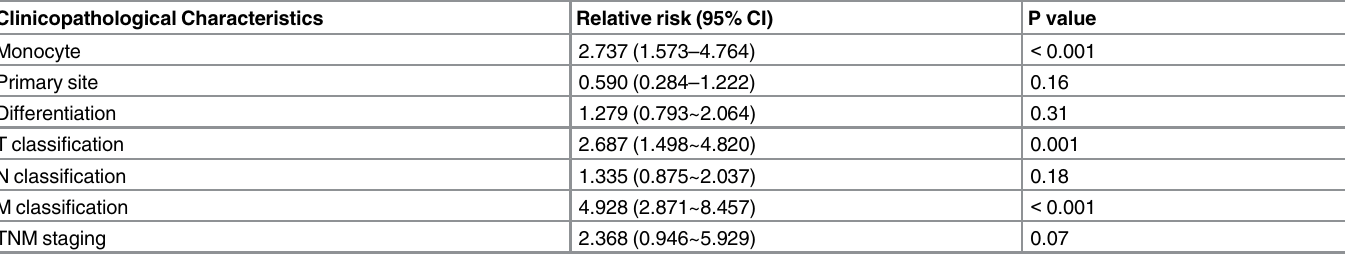
Table 4. Cox regression analysis for prognosis in 210 patients with colorectal cancer. Clinicopathological